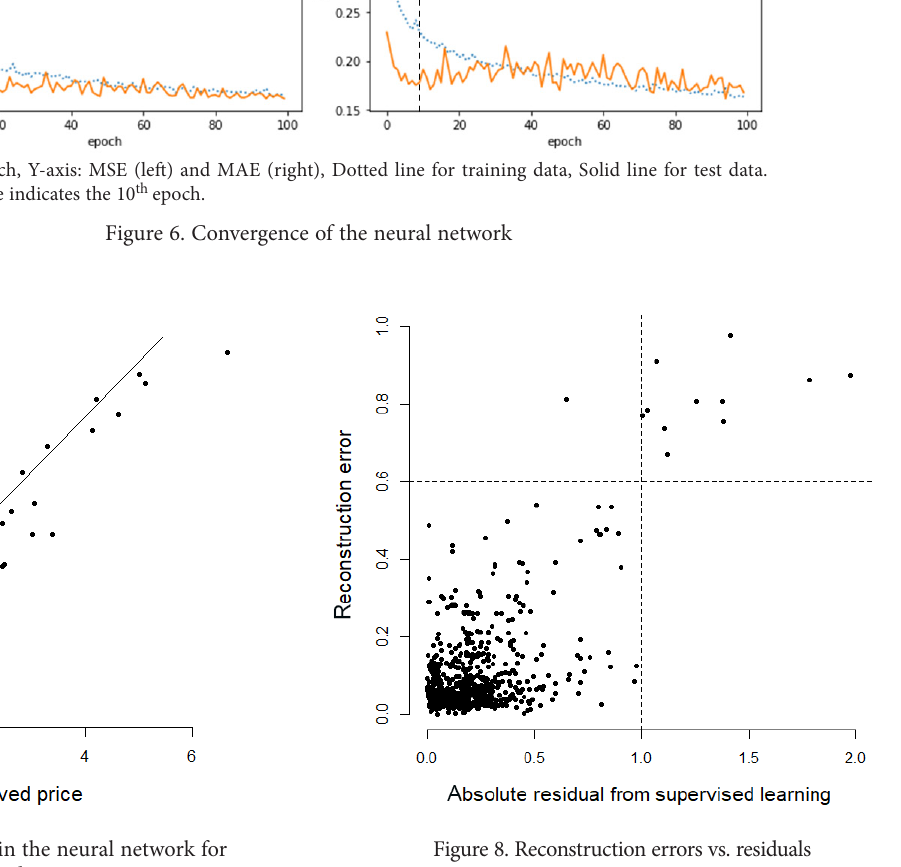
Figure 7. Goodness-of-fit in the neural network for the test data